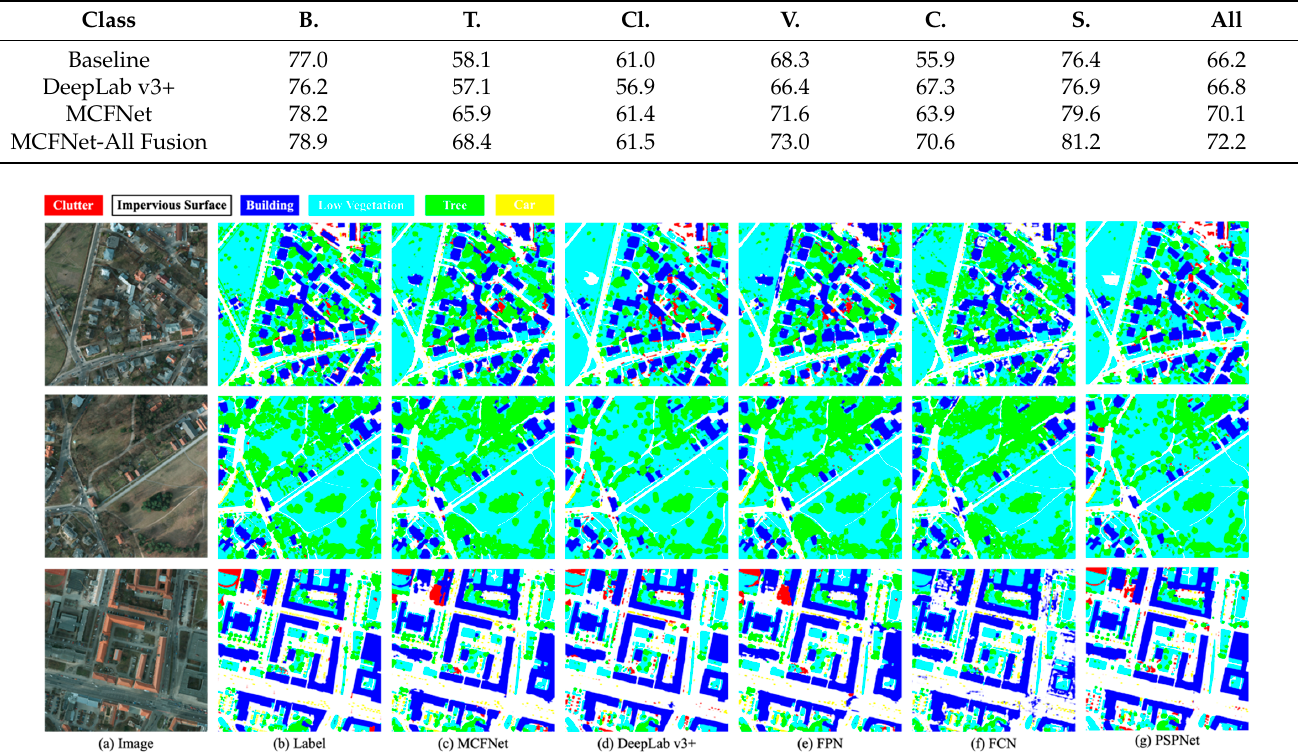
Figure 9. The display of segmentation output for Potsdam dataset.